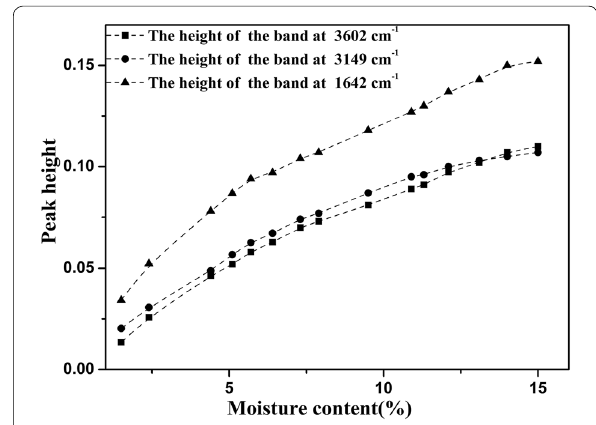
Fig. 6 The variation in the peak height for three peaks impacted by moisture sorption vs. MC. Quadrate dot: the 3602 cm − 1 band. Circular dot: the 3149 cm − 1 band. Triangle dot: the 1642 cm − 1 band